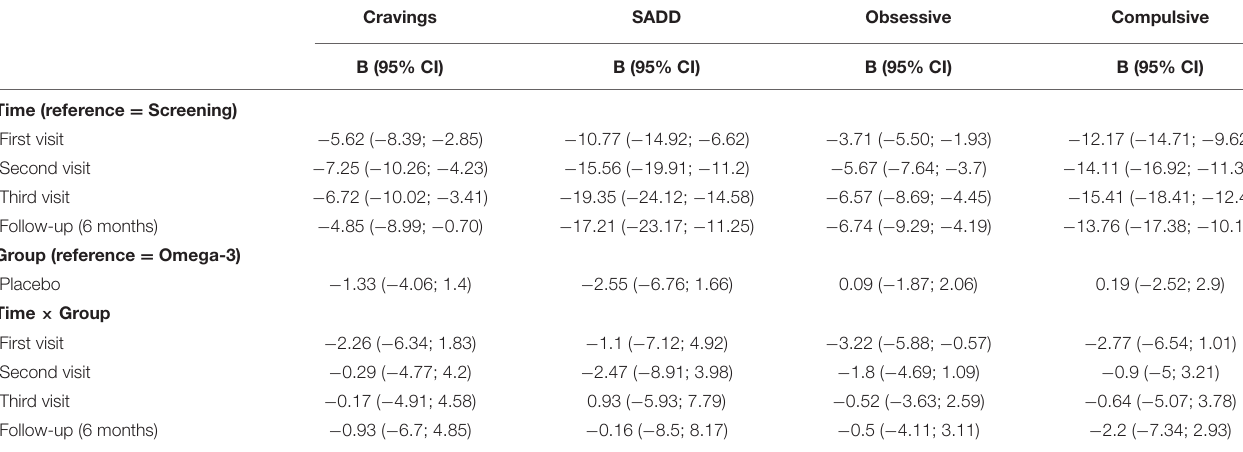
TABLE 4 | Non-standardized regression coefficients (followed by 95% confidence intervals) of the mixed models predicting outcomes related to alcohol dependence. Cravings SADD Obsessive